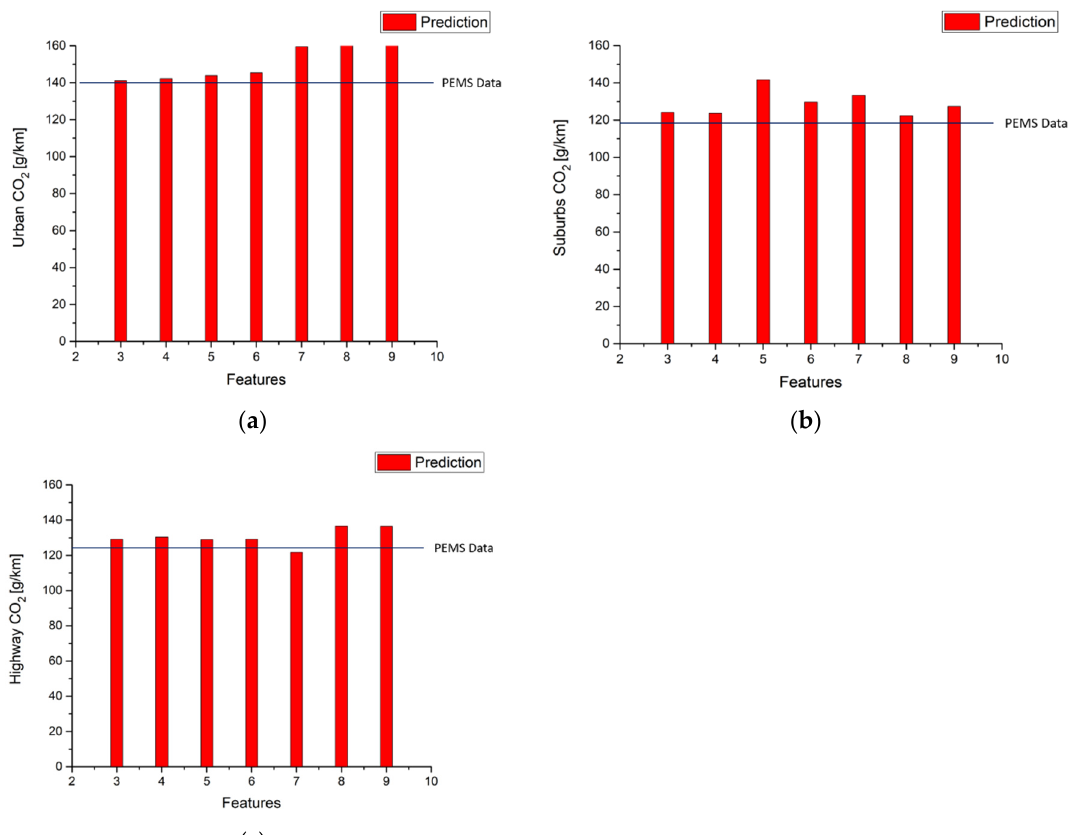
Figure 15. Second route NO x emission factor predictions by using route 1 NO x urban model ( a ) Urban; ( b ) Suburbs; ( c ) Highway.